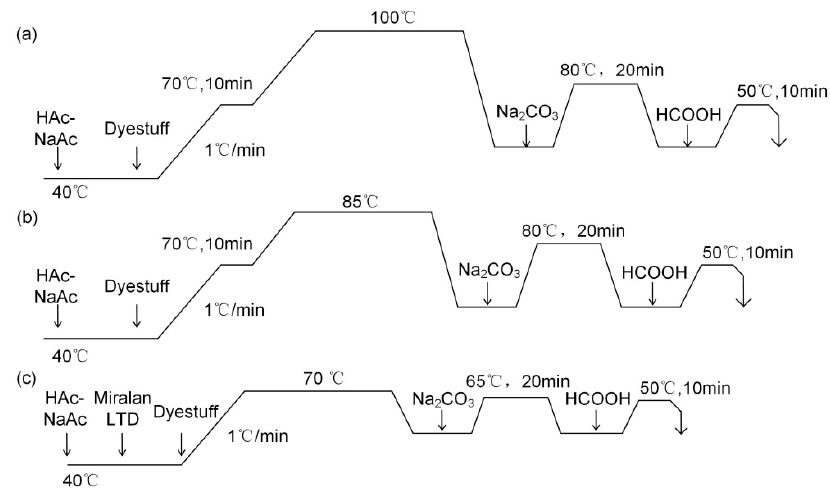
Figure 3. Dyeing curves of Lanasol Red CE and Blue CE with different temperatures: ( a ) 100 °C; ( b ) 85 °C; ( c ) 70 °C.